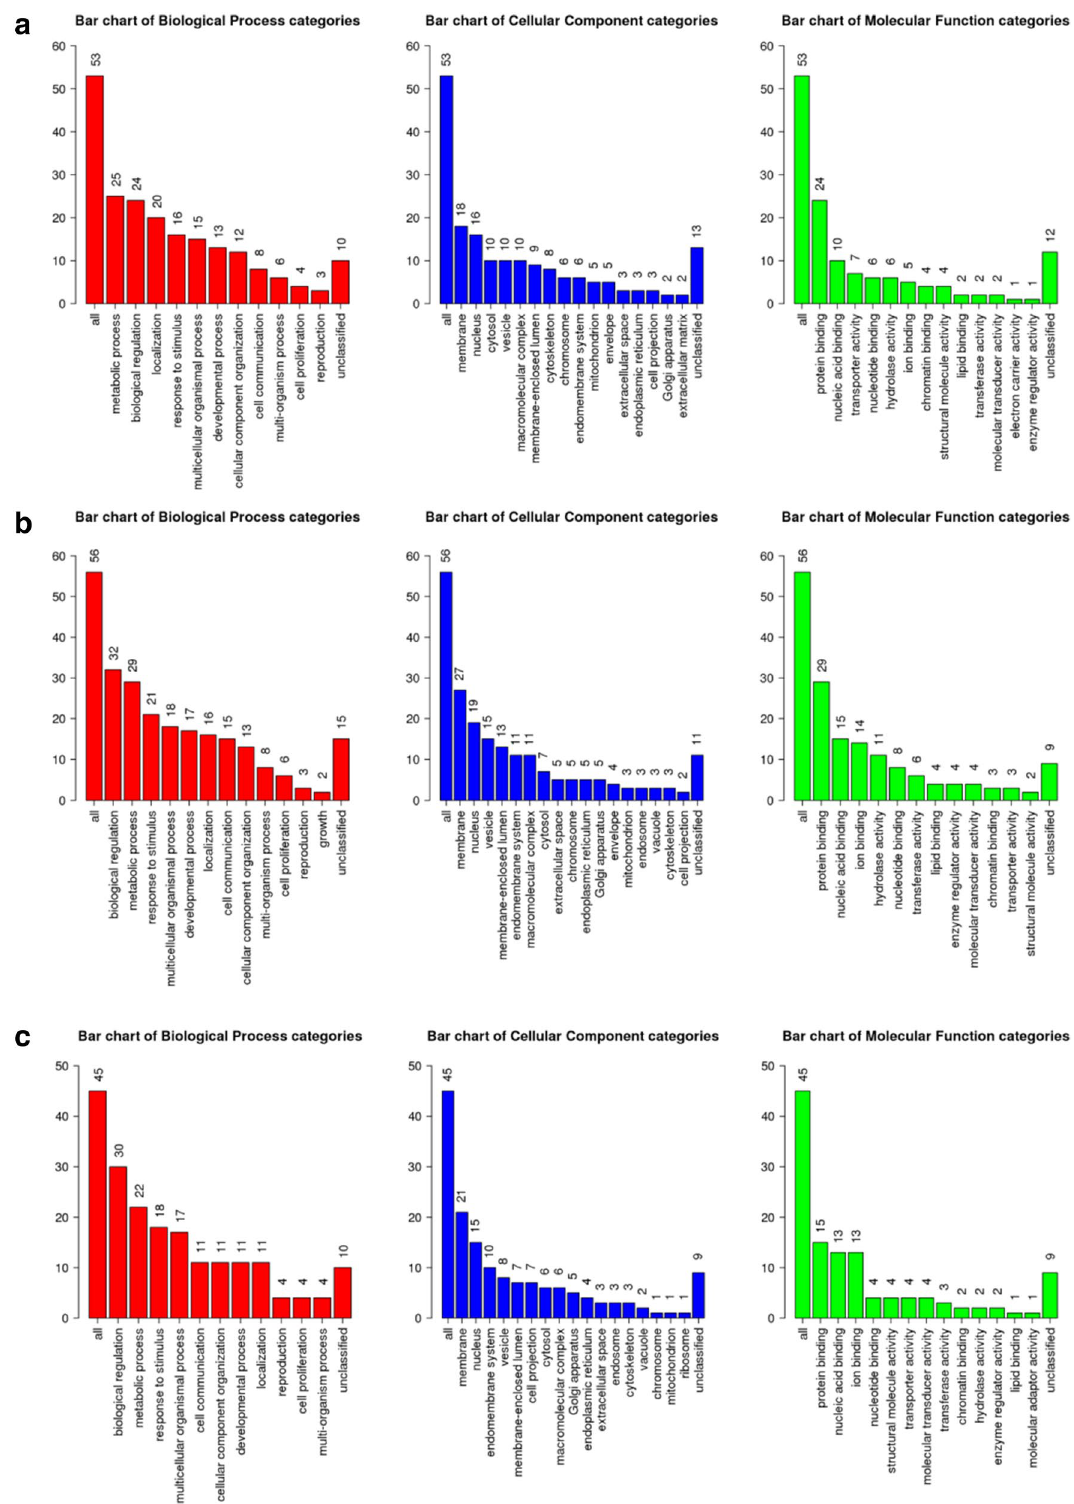
Figure 5. Results of GO slim summary for CvsE ( a ), CvsH ( b ), and CvsEvsH ( c ) DEGs, respectively. As a standard practice for this cut-down GO representation, the input genes were directly mapped to the standard GO subset based on the underlying GO annotation. The Y axis shows number of genes associated with each presented representative GO category. This plot is not based on statistical significance but solely on distribution of genes in the set of pre-fixed categories, selected by the GO database